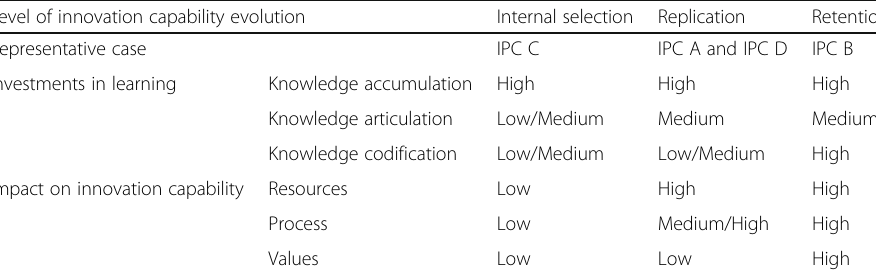
Table 3 Results